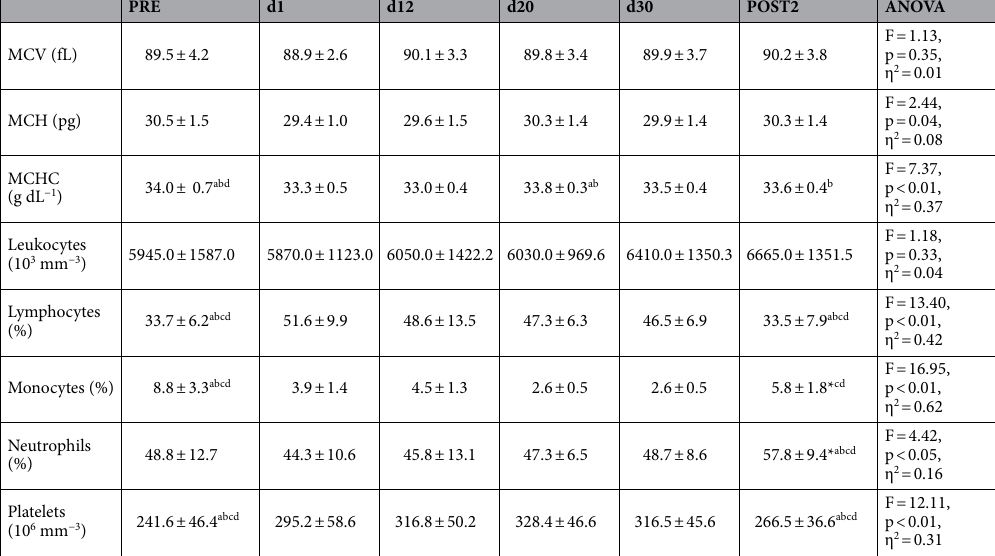
Table 1. Mean corpuscular volume (MCV), mean corpuscular hemoglobin (MCH), mean corpuscular hemoglobin concentration (MCHC), leukocytes, lymphocytes, monocytes, neutrophils and platelets from the before moment (PRE), at four moments during altitude exposure and after return to low altitude (POST2). Data are in mean ± standard deviation. * Different of PRE; a different of d1; b different of d12; c different of d20; d different of d30 (according to repeated ‐ measures ANOVA, using Newman–Keuls post hoc